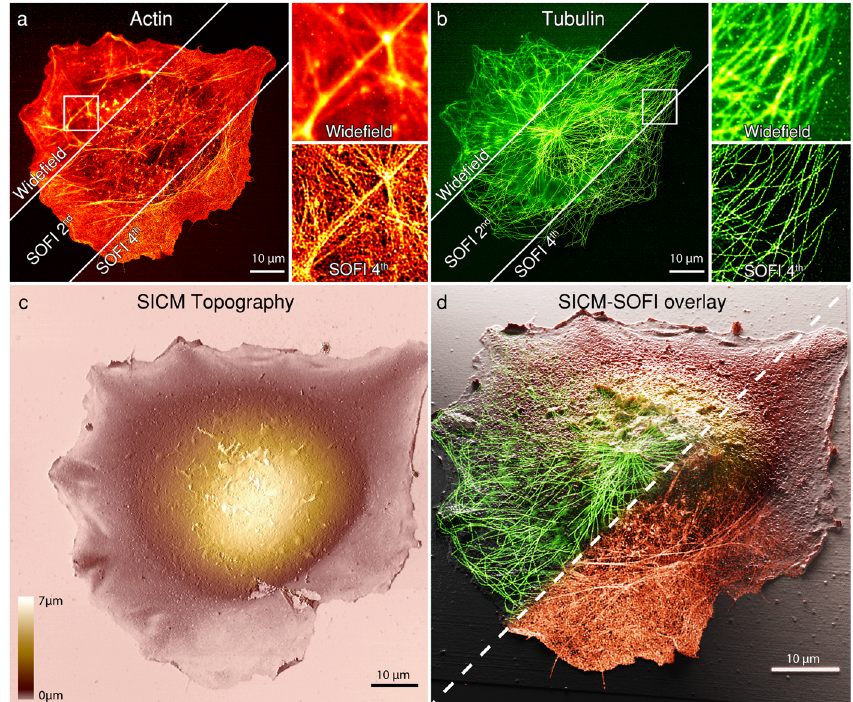
Fig. 2 Correlative 2D SICM-SOFI imaging cytoskeletal components of a fi xed COS-7 cell. a Large fi eld of view (100 × 100 μ m) 2D SOFI imaging of fi lamentous actin labeled with a phalloidin-f-HM-SiR self-blinking dye conjugate. b Subsequently, immunostained tubulin labeled with the self-blinking Abberior FLIP-565 dye was imaged. 10 μ m x 10 μ m zoom-ins of the standard deviation of the image stacks (wide fi eld) and 4 th order SOFI images are shown for a and b panels. 635 nm fl at- fi elded laser excitation was used for imaging f-HM-SiR and a 561 nm laser line for Abberior FLIP-565. Imaging was performed in a 25% glycerol and PBS mixture at pH = 8. c Corresponding topographical SICM image of the same cell acquired on a dedicated SICM setup. 1024 × 1024 pixels image (78 nm pixel size), acquired at a pixel acquisition rate of 200 Hz with a hopping height of 5 μ m. d 3D rendering of a correlative